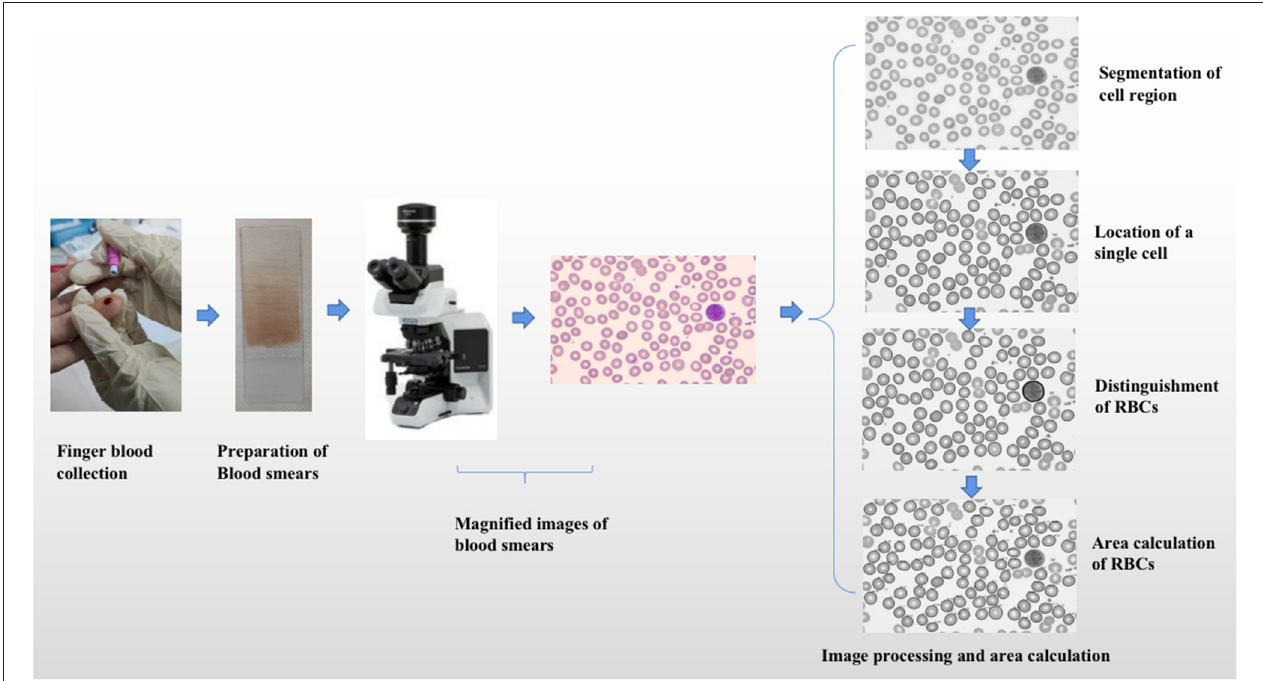
FIGURE 1 | The specific process of area calculation of red blood cells. The specific process included preparation of blood smears, magnified images of blood smears, and area calculation of red blood cells.